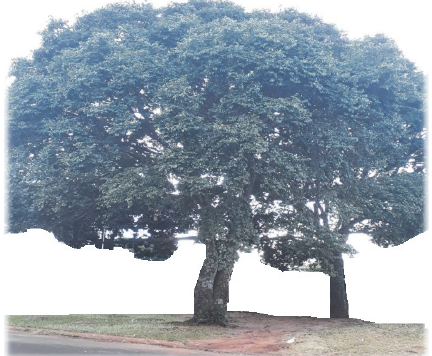
Figure 1: Hymenaea martiana Hayne–Fabaceae (jatob´a) (photo: Layza S Rocha and Valter A